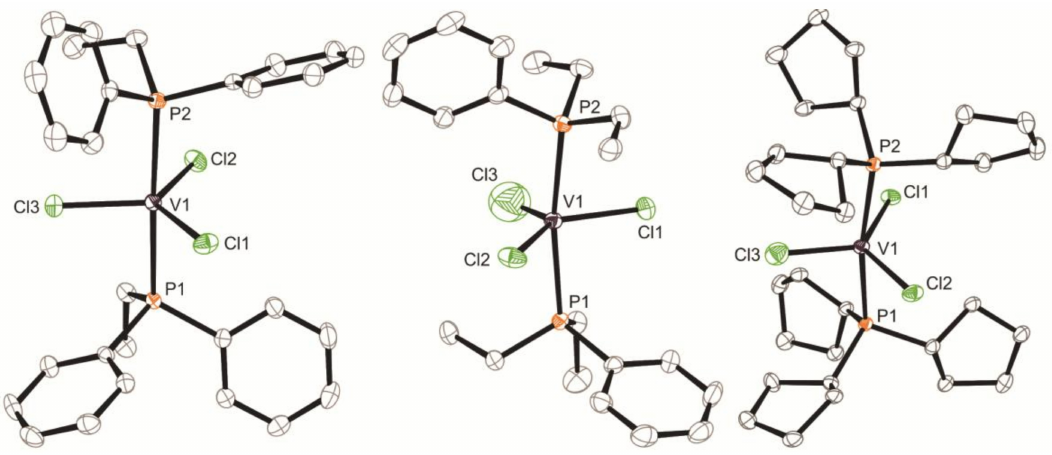
Figure 1. Molecular structures of VCl 3 (PEtPh 2 ) 2 ( 1c ) ( left ), VCl 3 (PEt 2 Ph) 2 ( 1g ) ( center ) and VCl 3 (PCyp 3 ) 2 ( 2a ) ( right ) with thermal ellipsoids drawn at 50% probability level. Hydrogen atoms omitted for